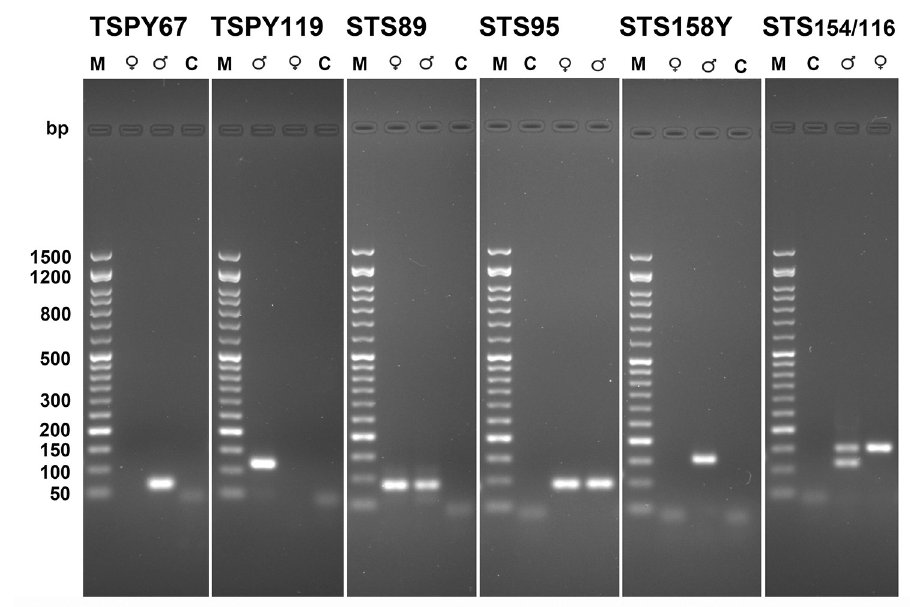
Fig 1. Agarose gel electrophoresis of amplicons on modern DNA. Electrophoretic analysis of amplicons generated in qPCR using the primers TSPY67 , TSPY119 , STS89 , STS95 , STS158Y , STS154/116 , with male ( ♂ ) and female ( ♀ ) human DNA. M) SharpMass ™ 50 molecular weight marker—Ready-to-load DNA Ladder (Euroclone S.p.A). C) control without template DNA. Agarose gels are 2.2% and stained with ethidium bromide as reported in Materials and